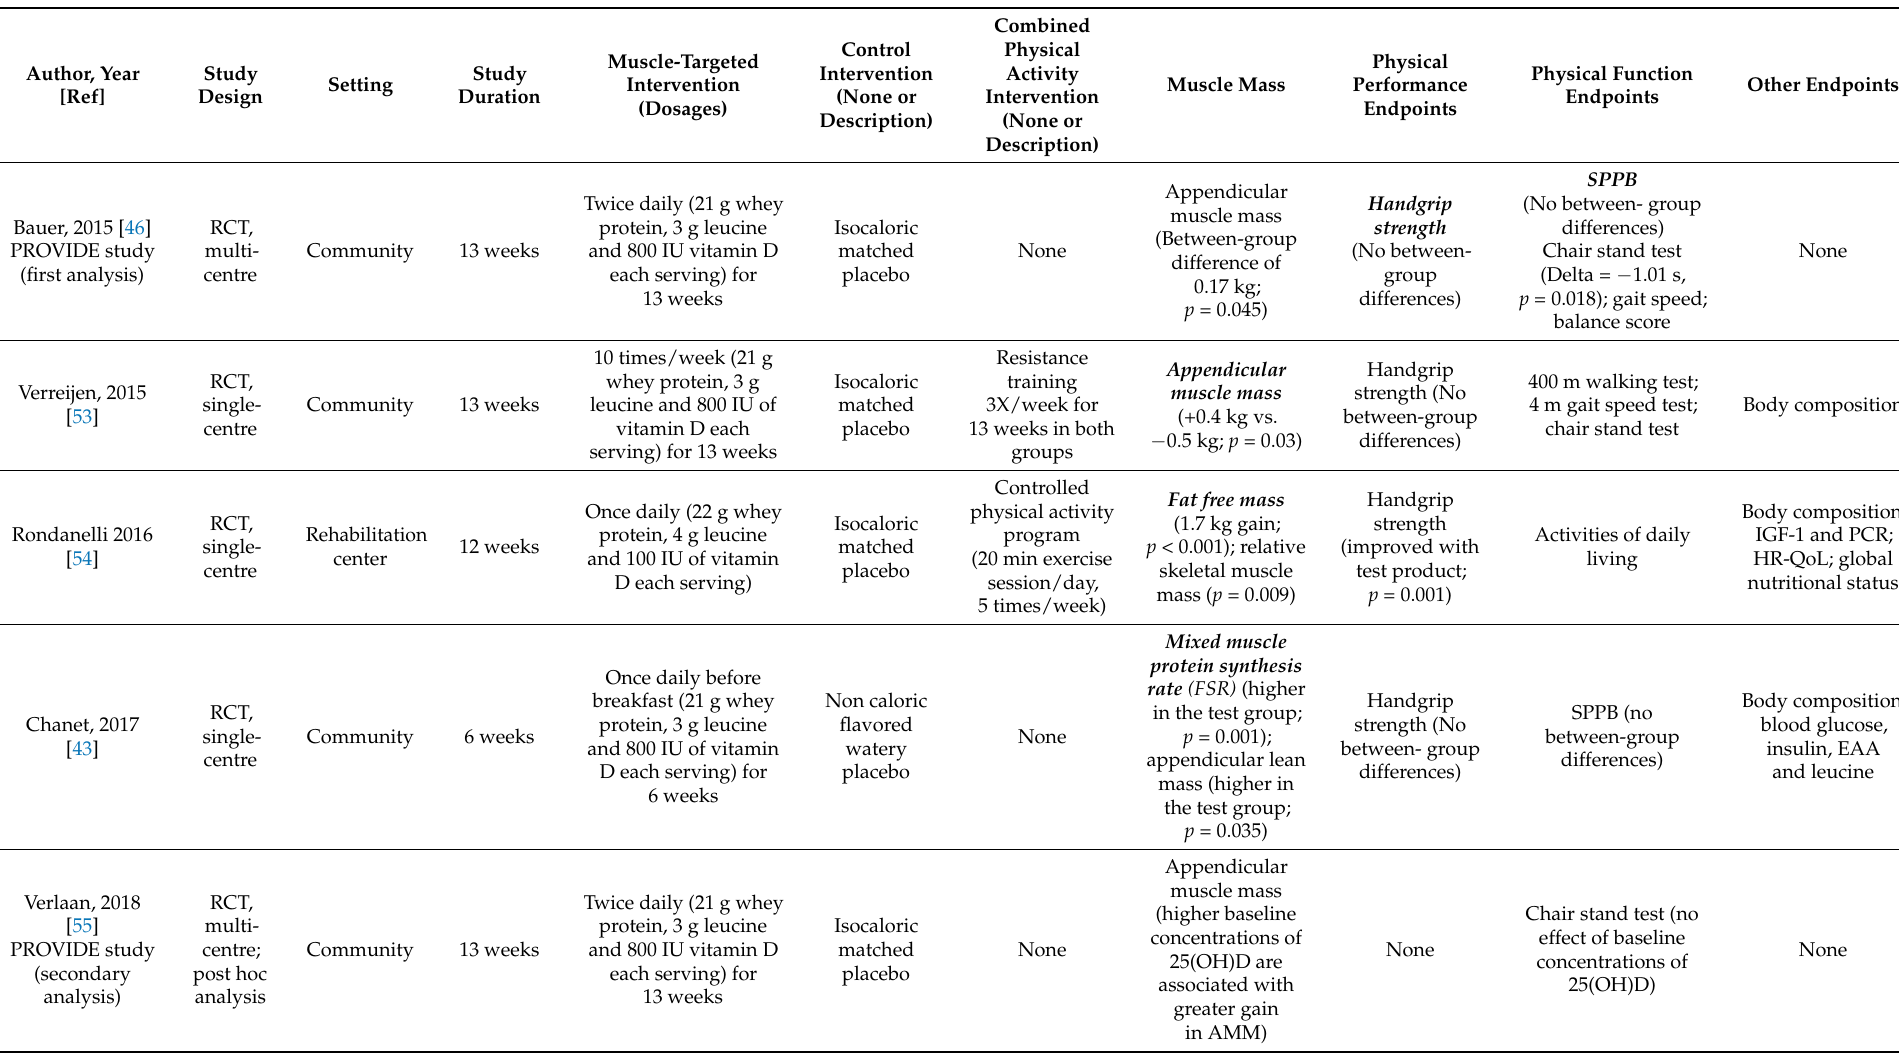
Table 3. Main characteristics of trials addressing the efficacy of muscle-targeted oral nutritional